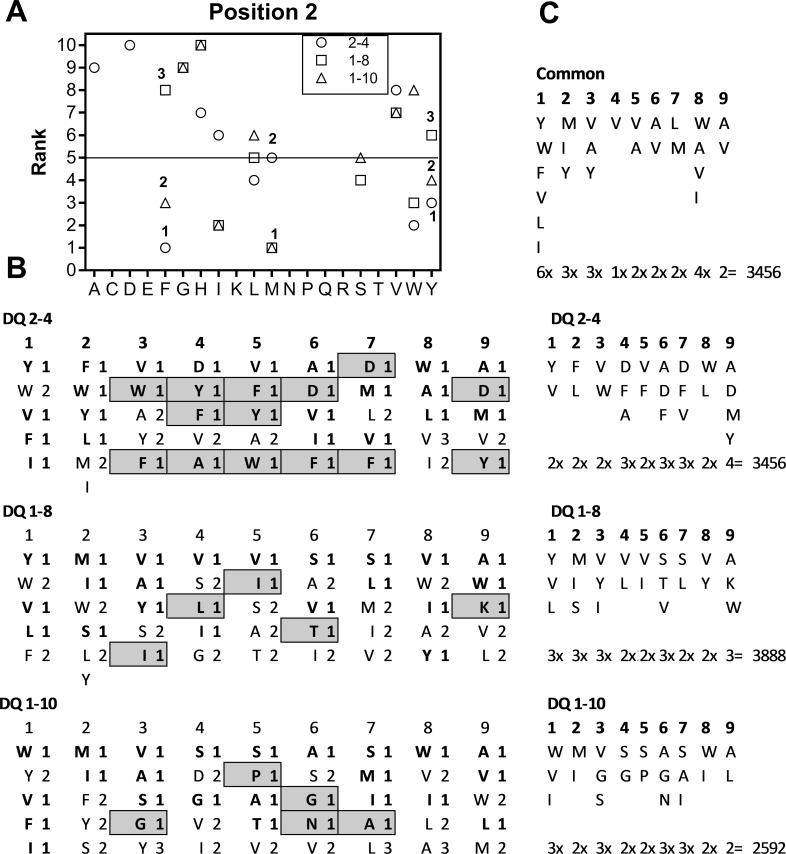
Selection of amino acids for combination sequences.(A) To determine the highest ranked amino acids selective for, or common to MPSLs for 3 IRL dolphin proteins (DQ1-08 □, DQ1-10 Δ and DQ2-04 ○), each of the 9 positions the ranking data for all 3 MPSLs were superimposed on a single graph (sample graph for position 2 is shown). (B). The top 5 amino acids at each position were given a value 1–3 depending on their rank in the composite graph For example, Tyrosine (Y) in position 2 would be assigned a value of 1 for DQ2-4, 2 in DQ1-10, and is not in the top 5 for DQ1-8; Methionine (M) would be given a value of 1 for both DQ1-8 and DQ1-10. (C) Combinations of the common or most selective amino acids amino acids used to generate sequences a total of 13,392 sequences were generated.